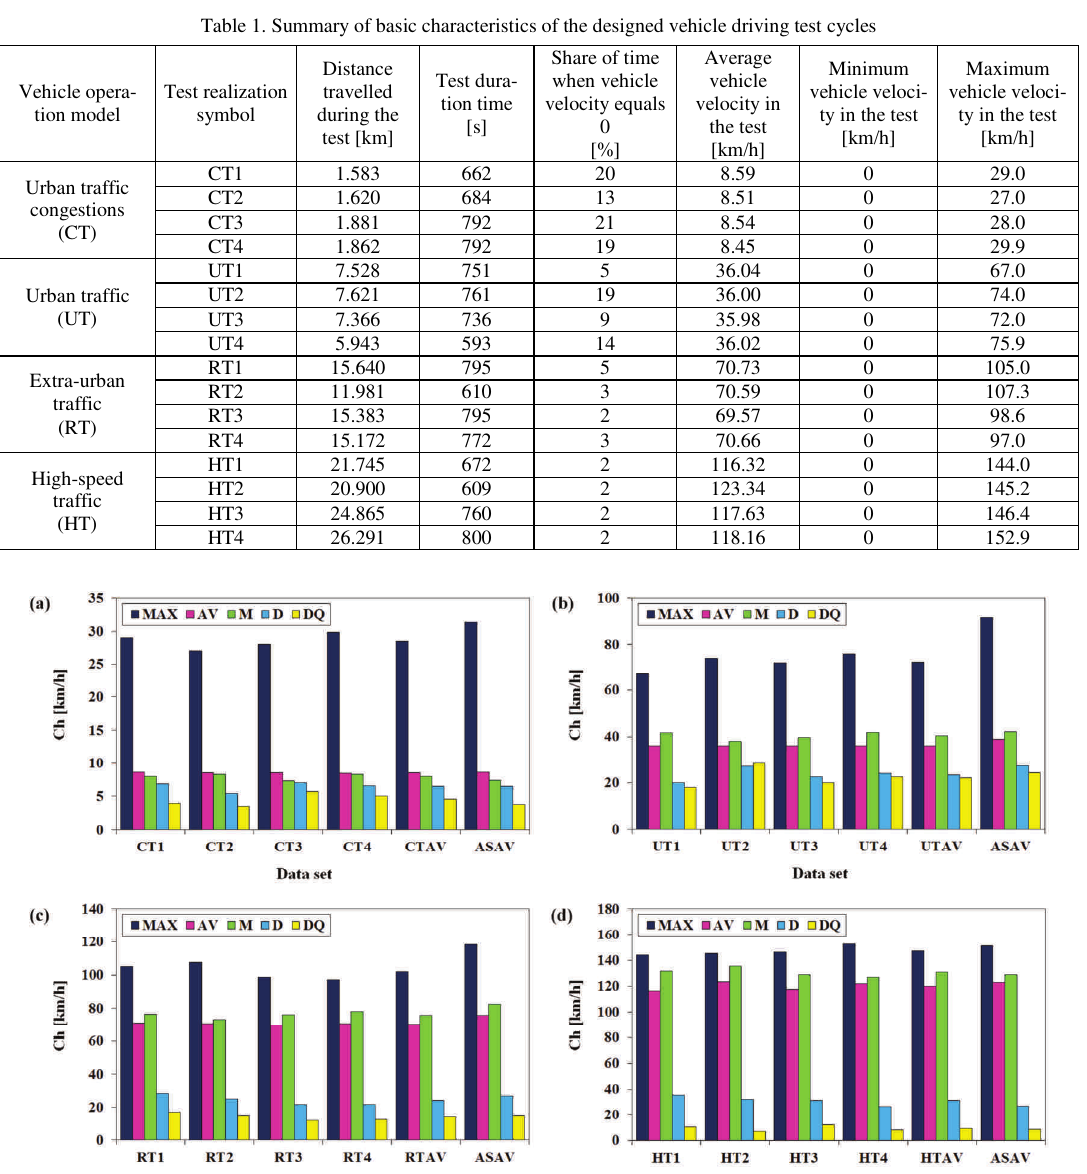
Table 1. Summary of basic characteristics of the designed vehicle driving test cycles Vehicle opera- tion model